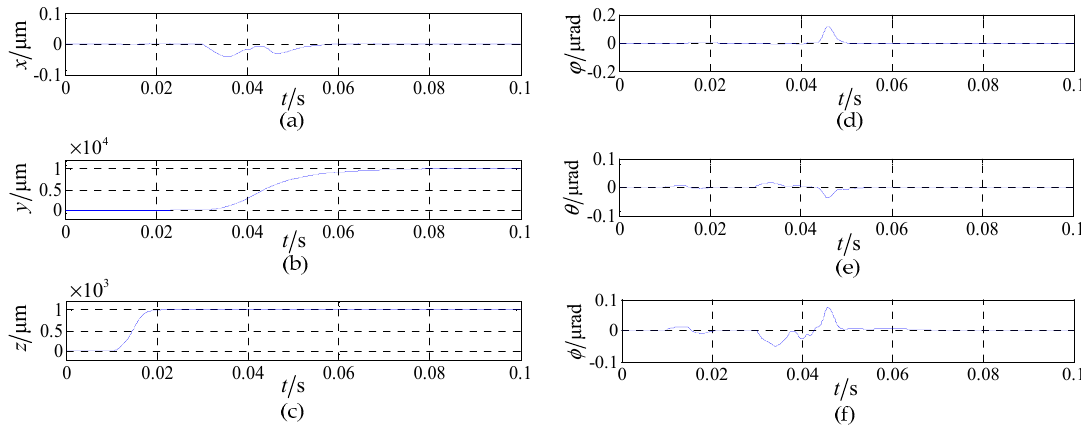
Figure 10. Displacement curve of the control system based on the interpolation method. In Figure 9, the position disturbance on x -axis caused by y -axis and z -axis position variation is from − 0.081 μ m to 0.076 μ m, the position disturbance on ϕ -axis is from − 0.51 μ rad to 0.73 μ rad, the